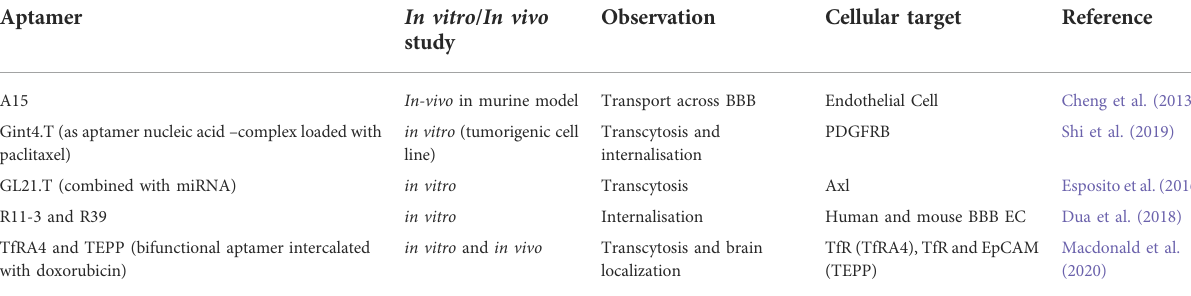
TABLE 2 Studies on aptamers to show transport across